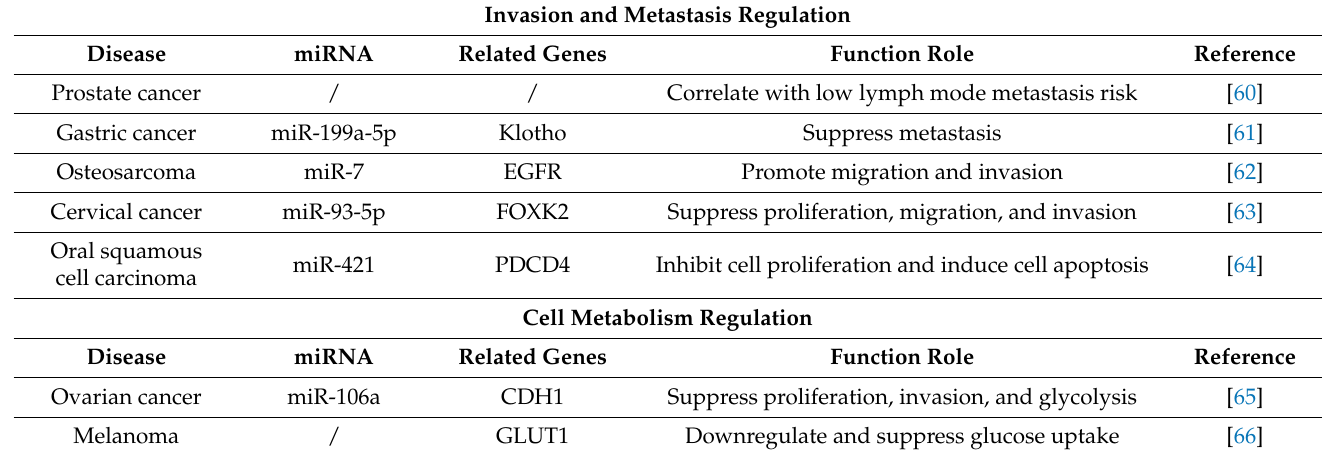
Table 5. Target and role of circ-ITCH in